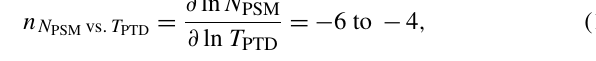
Table 4. The parameters of the nucleation rate function with the best correspondence between the measured and the simulated data. The ranges of variation represent the resolution with which the ex- ponents were altered during inverse modeling.